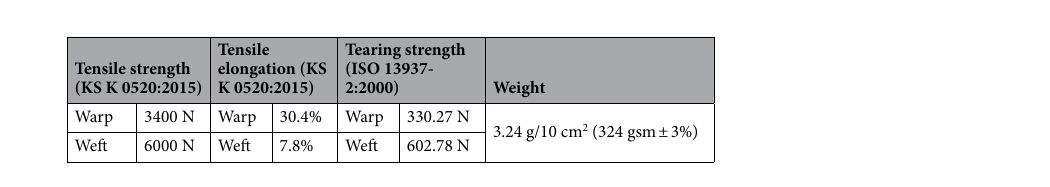
Table 2. Features of double-weave aramid